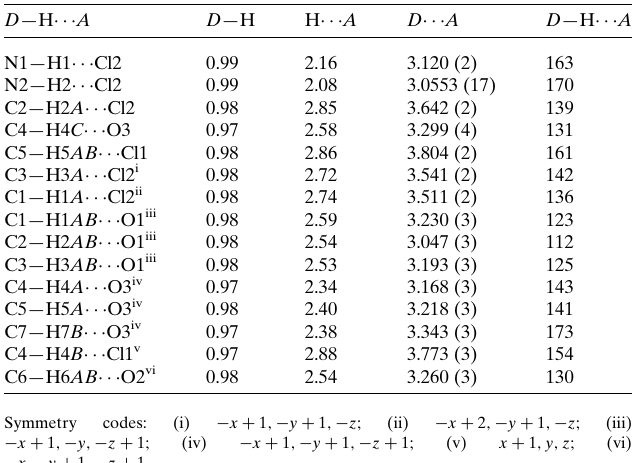
Table 1 Hydrogen-bond geometry (A˚ , (cid:4)